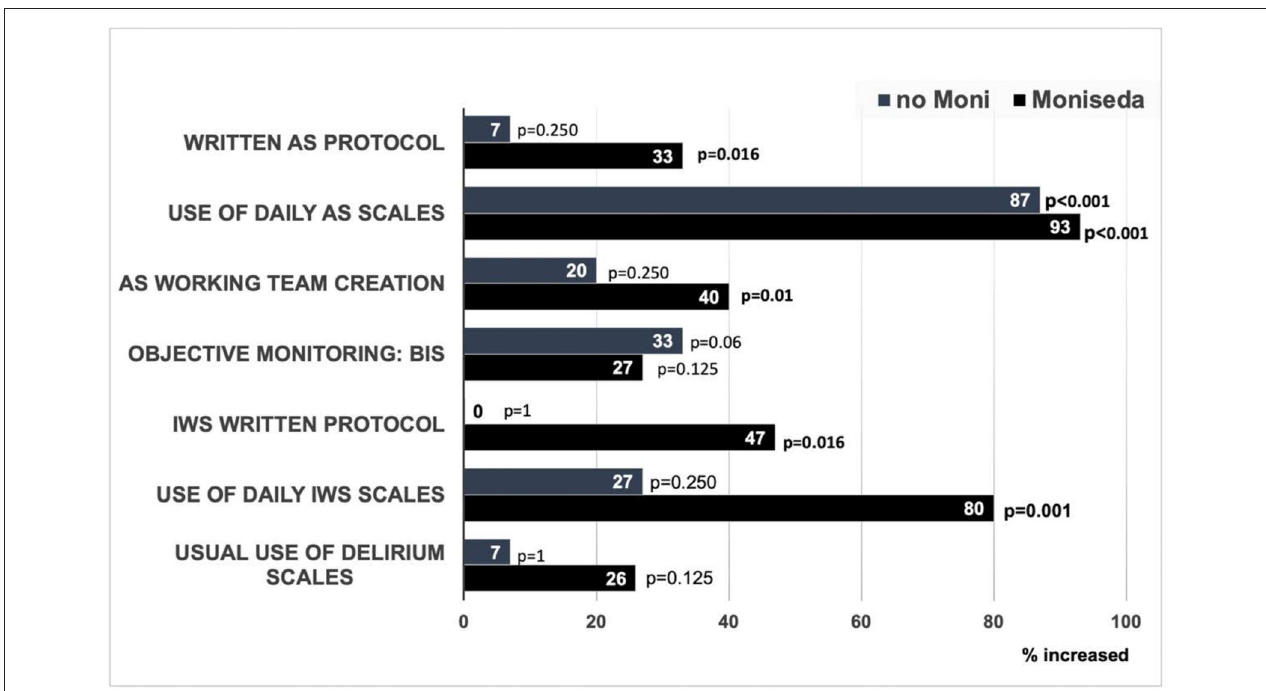
FIGURE 1 | Improvement in analgosedation survey 2020 compared to 2015 in both the MONISEDA and non-MONISEDA groups. AS, analgosedation; BIS, bispectral index, IWS, iatrogenic withdrawal